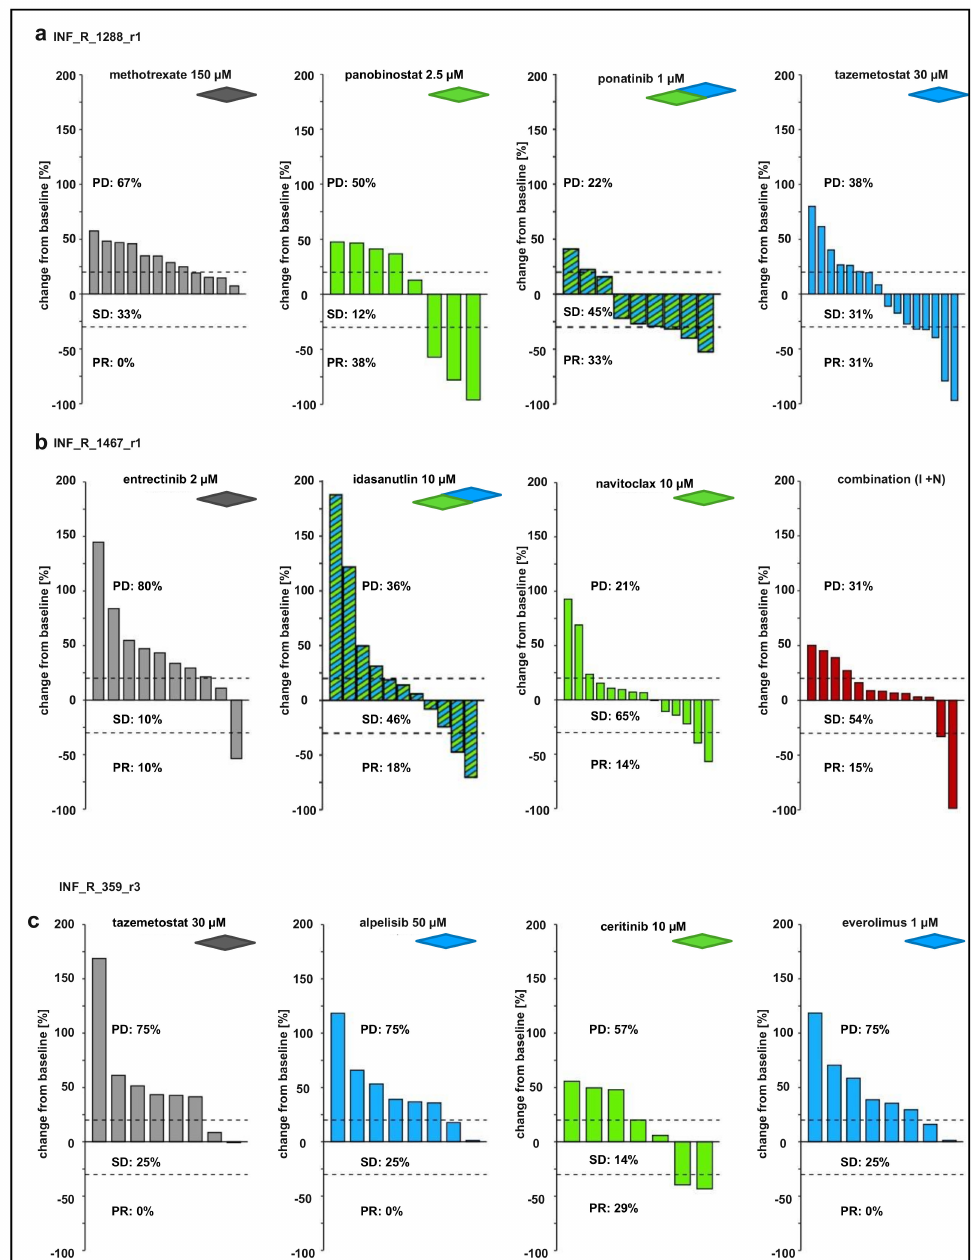
Figure 5. Waterfall plots demonstrating change in tumor volume for ( a ) the INF_R_1288_r1 rhabdoid tumor zPDX model (methotrexate with 12 individual embryos and ponatinib with 9 individual embryos, each from one experiment; panobinostat with eight individual embryos and tazemetostat with 16 individual embryos, both from two pooled experiments), ( b ) the INF_R_1467_r1 eRMS zPDX model (idasanutlin with 11 individual embryos from one experiment; entrectinib with ten individual embryos and navitoclax with 14 individual embryos, both from two pooled experiments), and ( c ) the INF_R_359_r3 neuroblastoma zPDX model (tazemetostat with eight individual embryos, alpelisib with eight individual embryos, ceritinib with seven individual embryos and everolimus with eight individual embryos, all from one experiment). Depicted is the change in tumor volume (%) for each individual zebrafish early larvae engrafted with tumor cells, from baseline (day one = start of the treatment) to day three after tumor implantation. Numbers indicate the percentage of early larvae with progressive disease (PD), stable disease (SD) and partial response (PR) in each treatment group on day